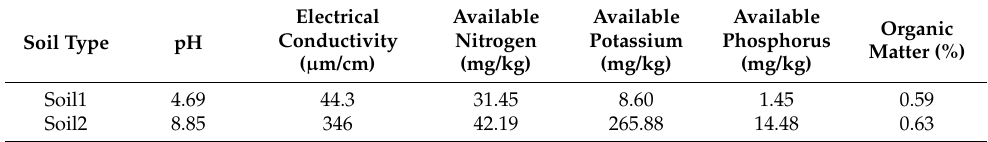
Table 1. The chemical properties of soil samples.